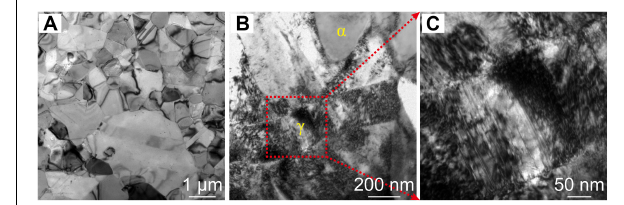
FIGURE 6 | (A) TEM image of the IA (680 ◦ C/240 min) steel before tensile test. (B) TEM image of the IA (680 ◦ C/240 min) steel after tensile test. (C) The magnified view of dashed rectangle in (C) showing the formation of deformation twinning in the austenite grain.